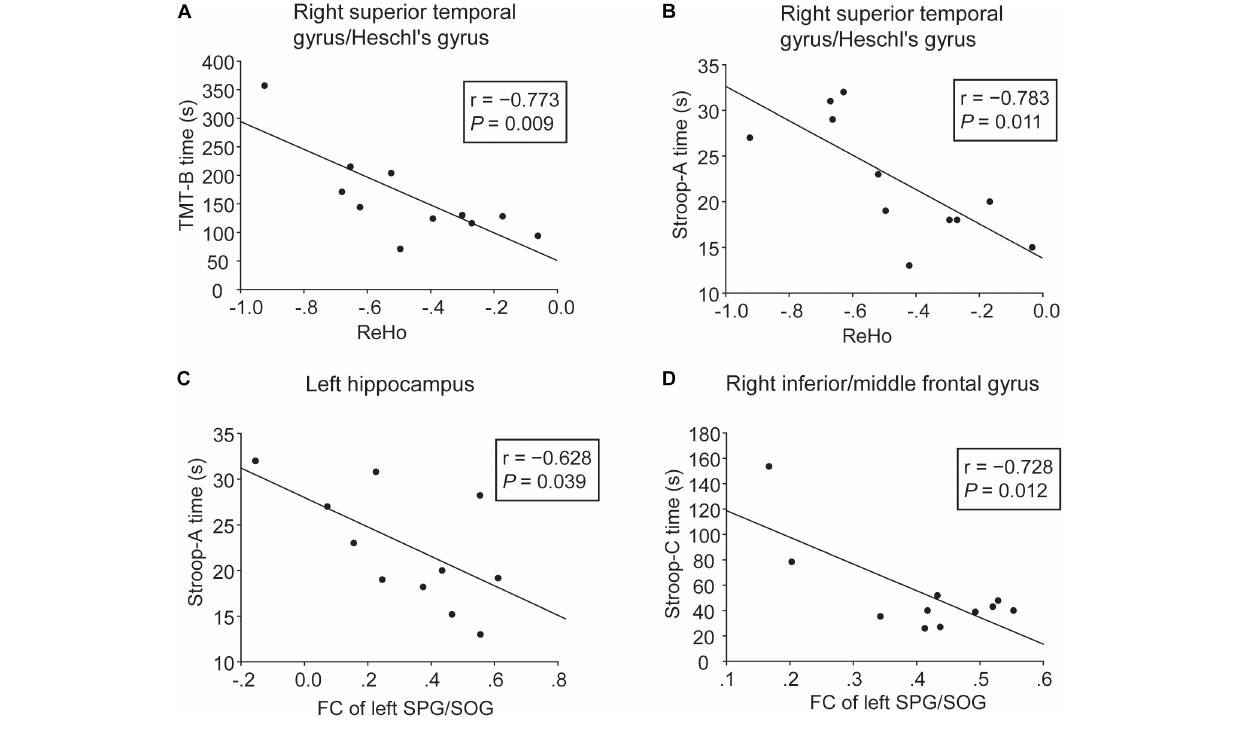
FIGURE 4 | Correlation analyses between cognitive function and ReHo or FC in the WMH with CI group. (A,B) Significant negative correlation was shown between cognitive performances (TMT-B and Stroop-A) and ReHo in the right superior temporal gyrus/Heschl’s gyrus. (C,D) Significant negative correlation was shown between cognitive performances (Stroop-A and Stroop-C) and FC of the left SPG/SOG with the left hippocampus and the right inferior/middle frontal gyrus. Three WMH with CI subjects failed to perform these tests due to subjective unwillingness or